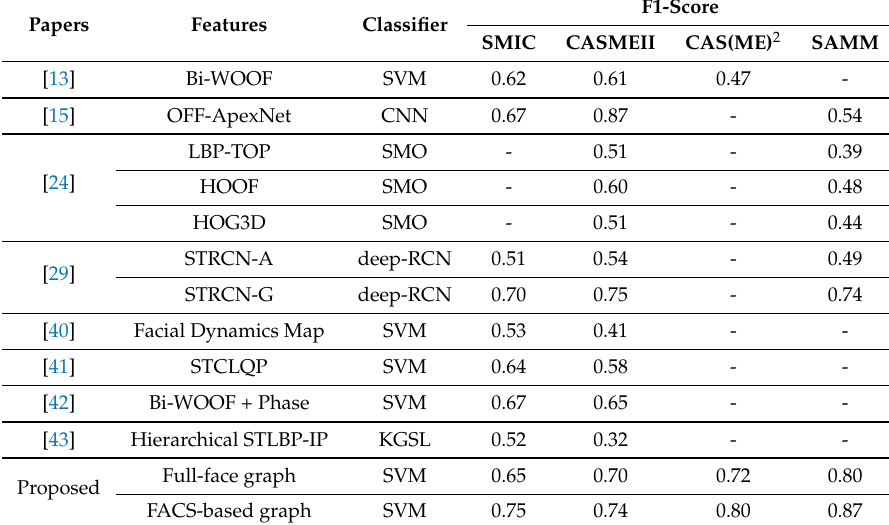
Table 8. LOSOCV: F1-score of the proposed algorithm vs other